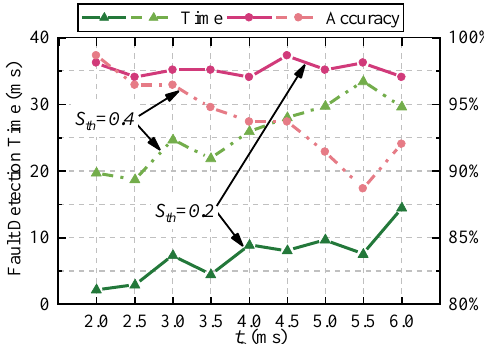
Figure 13. Detection time and accuracy with two S th .